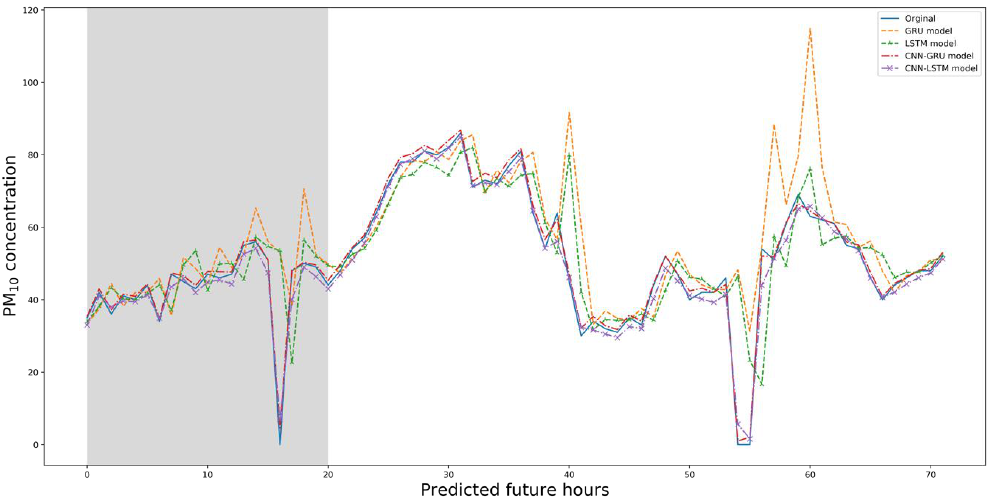
Figure 12. Predicted 3-day PM 10 concentrations; all models.